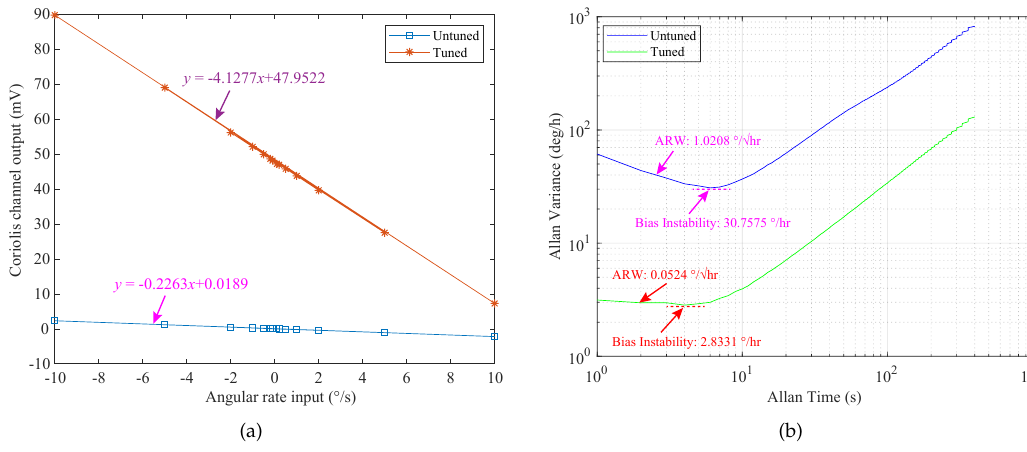
Figure 13. Scale factor and Allan variance curves under mode-matching and mode mismatch conditions: ( a ) the scale factor; ( b ) the Allan variance